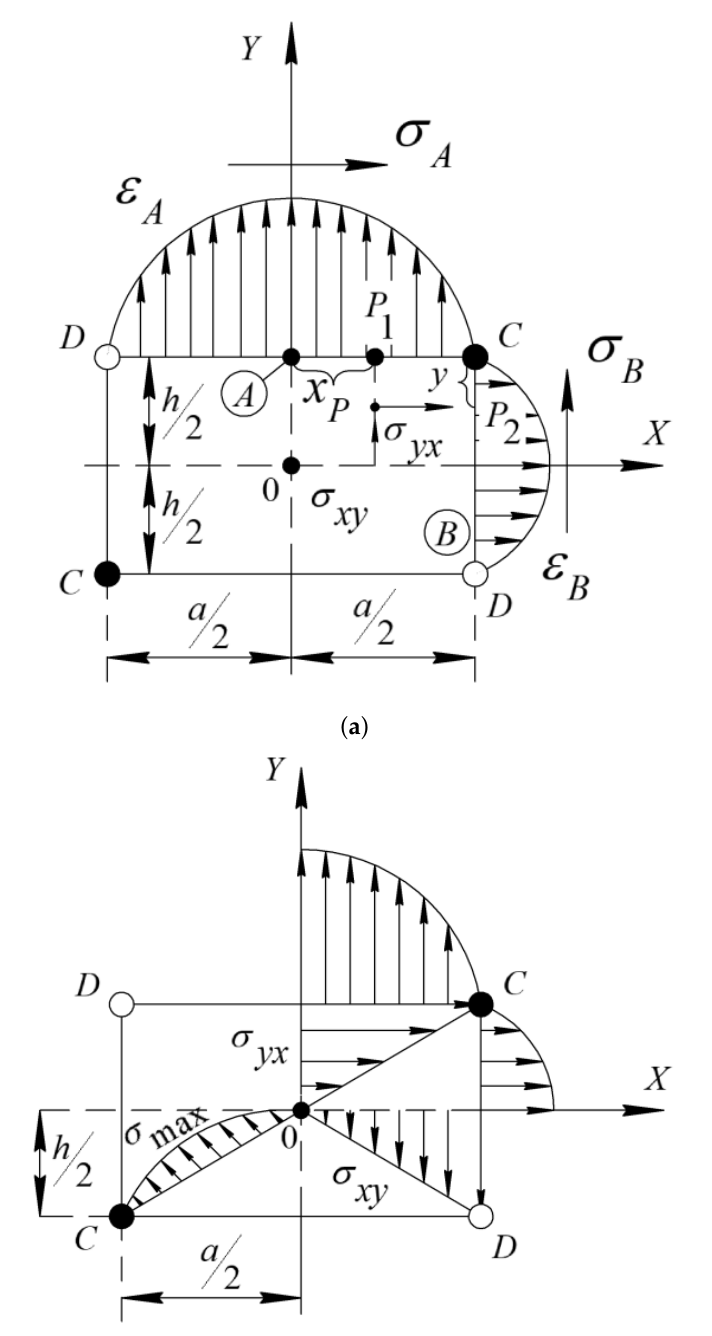
Figure 3. Diagrams of stress distribution over the cross section of the investigated PE sample at free damping torsional oscillations, excited in this sample: ( a ) along the faces; and ( b ) along the diagonals. Calculation of the error of these measurements on the maximum values of the stresses σ ij occurring on the surfaces of the faces and cross-section of the studied samples and the corresponding values of shear deformation γ ij does not exceed